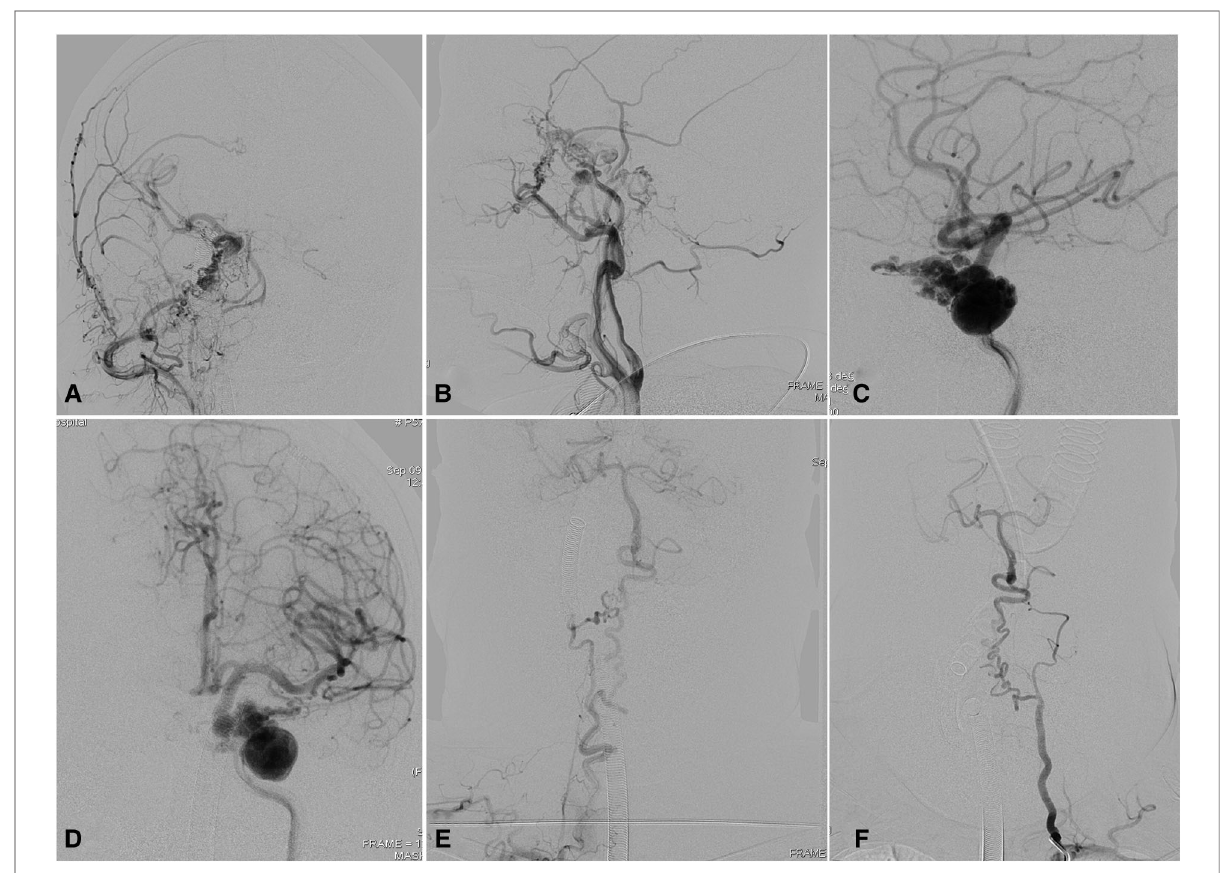
FIGURE 5 Complicated rete aneurysm with bilateral ICA agenesis in a 65-year-old woman. Angiograms in ( A ) anterior and ( B ) lateral views showing rete mirabile between the ECA branches and distal ICA remnant with right ICA agenesis. Angiograms via left ICA in ( C ) anterior and ( D ) lateral views showed that complicated rete aneurysm was developed in the left with segmental ICA agenesis. Elongated and underdeveloped ( E ) right and ( F ) left vertebral arteries. ECA, external carotid artery. ICA, internal carotid